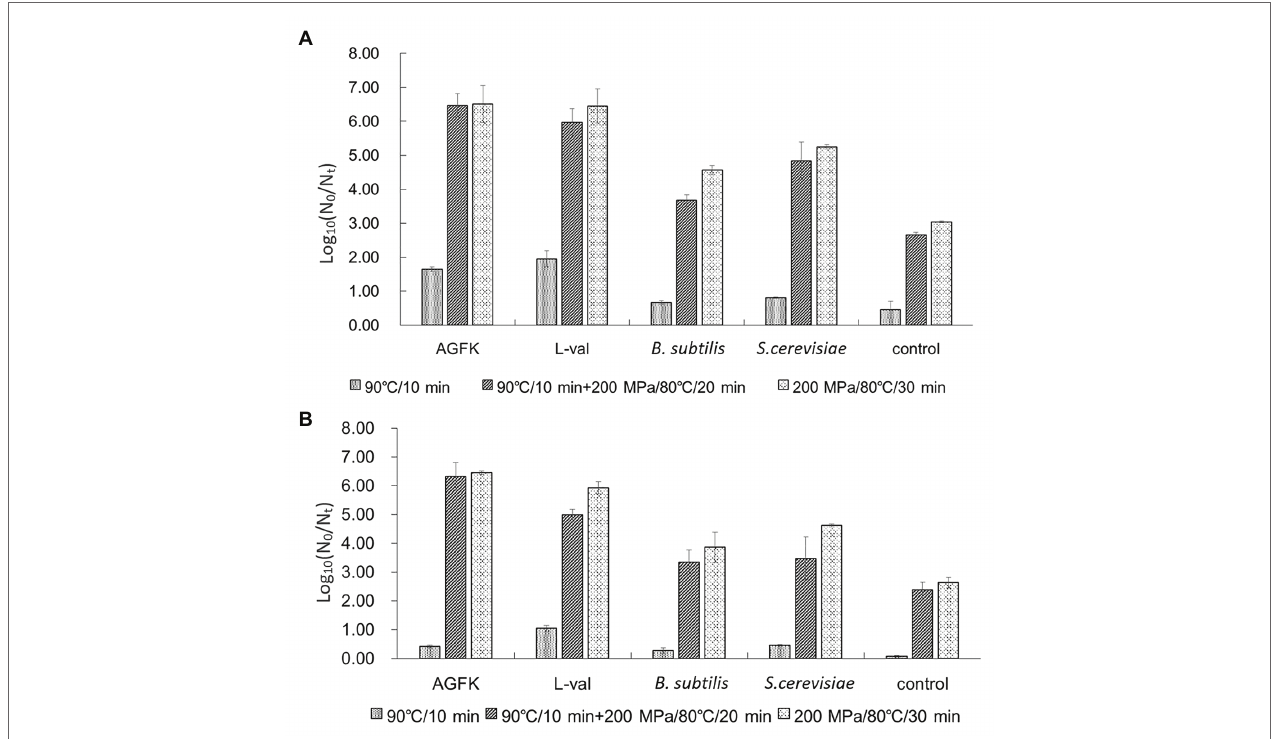
FIGURE 7 | The effect of supernatants from B. subtilis and S. cerevisiae on spore germination and inactivation. (A) The germination of B. subtilis 168 spores with different treatments. (B) The inactivation of B. subtilis 168 spores with different treatments. The supernatants from B. subtilis and S. cerevisiae combined with temperature and pressure were performed